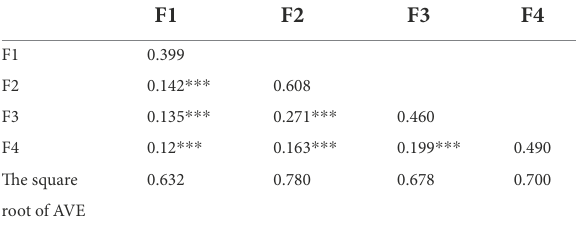
TABLE 5 Discriminant validity of the Health Behavior